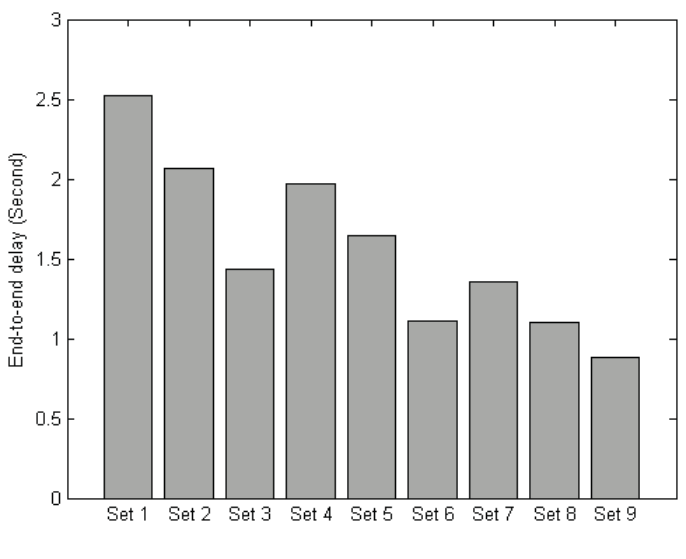
Figure 16. End-to-end delay of the protocol